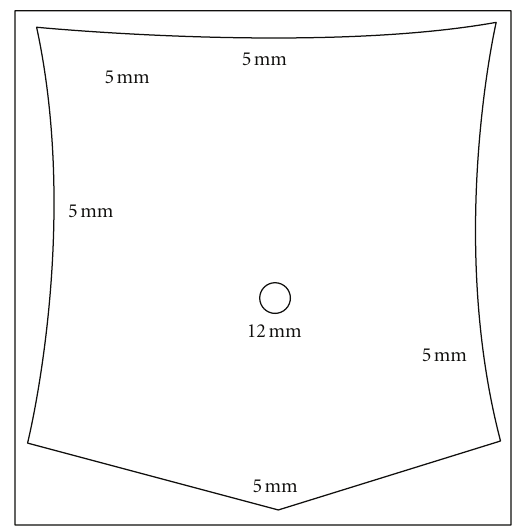
Figure 2: Port placement. The infraumbilical port was placed with the open Hasson technique and all the 5mm trocars were